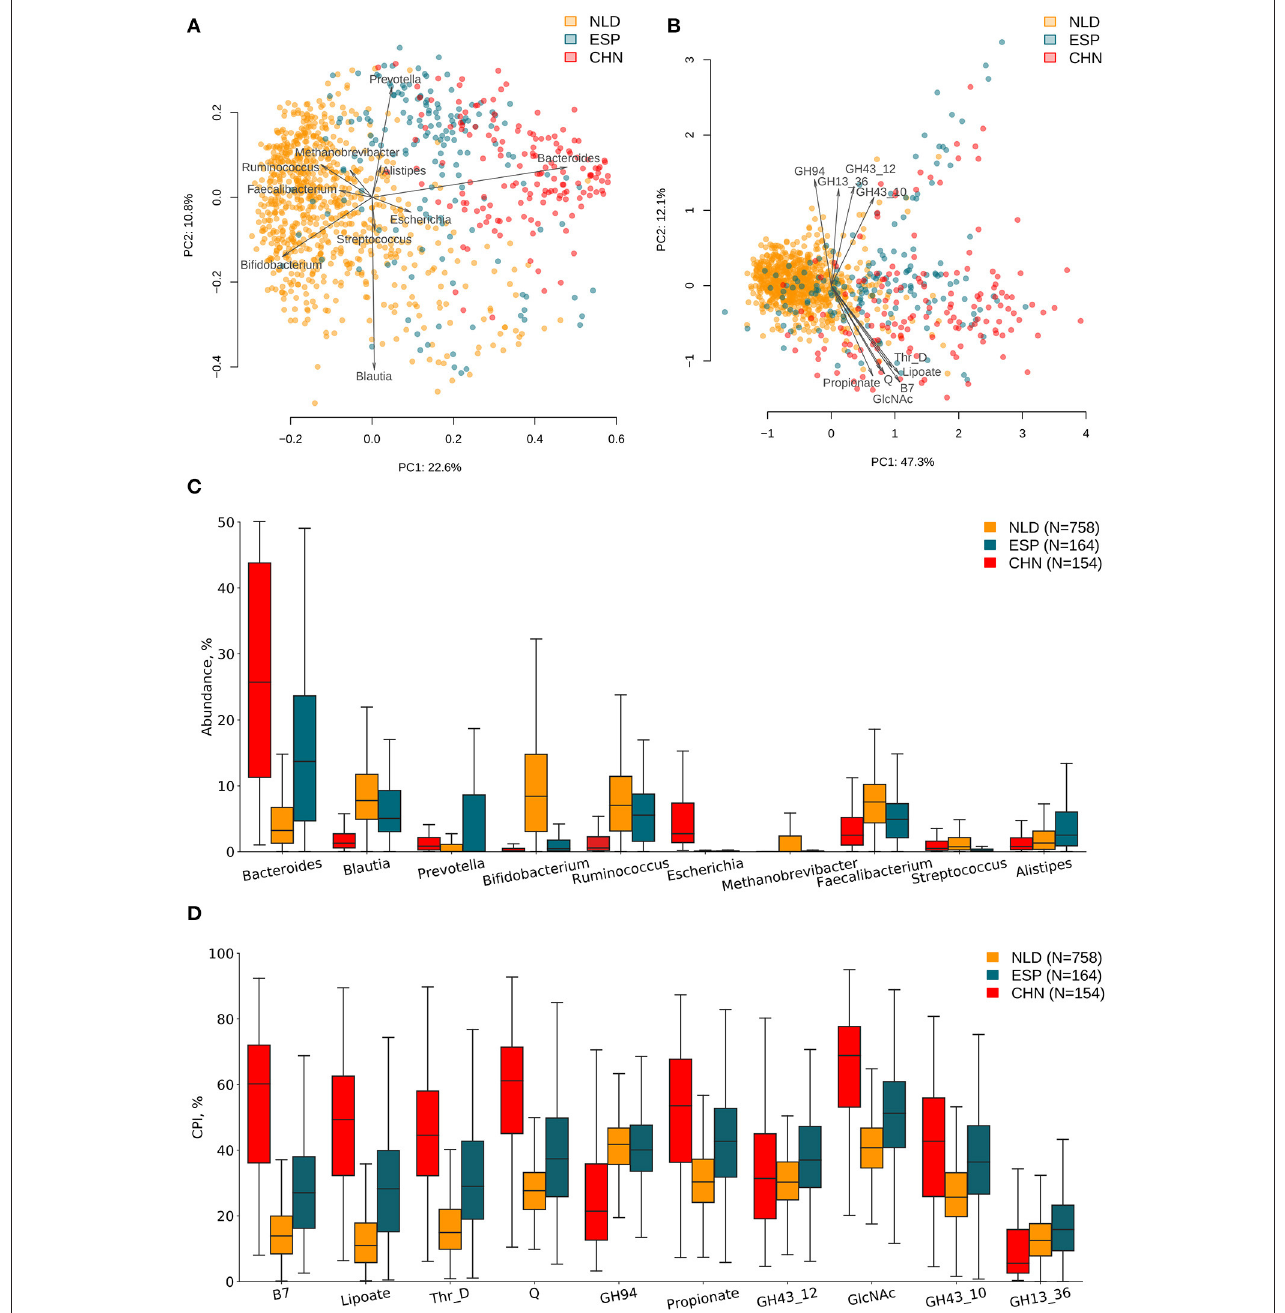
FIGURE 2 | Differences in microbiome composition and metabolic functions of samples from three investigated IBD datasets. (A) PCoA analysis of samples using taxonomic features (genera abundance) and Bray–Curtis dissimilarity metric for distance calculation. (B) PCA analysis of samples using metabolic phenotype features (CPI) for distance calculation. Arrows show top 10 features in terms of the explained variance in the given axes. Arrow length is proportional to the percent of variance explained by the feature. Distribution of taxonomic abundances (C) and Community Phenotype Index (CPI) values (D) for the corresponding top 10 features across three IBD